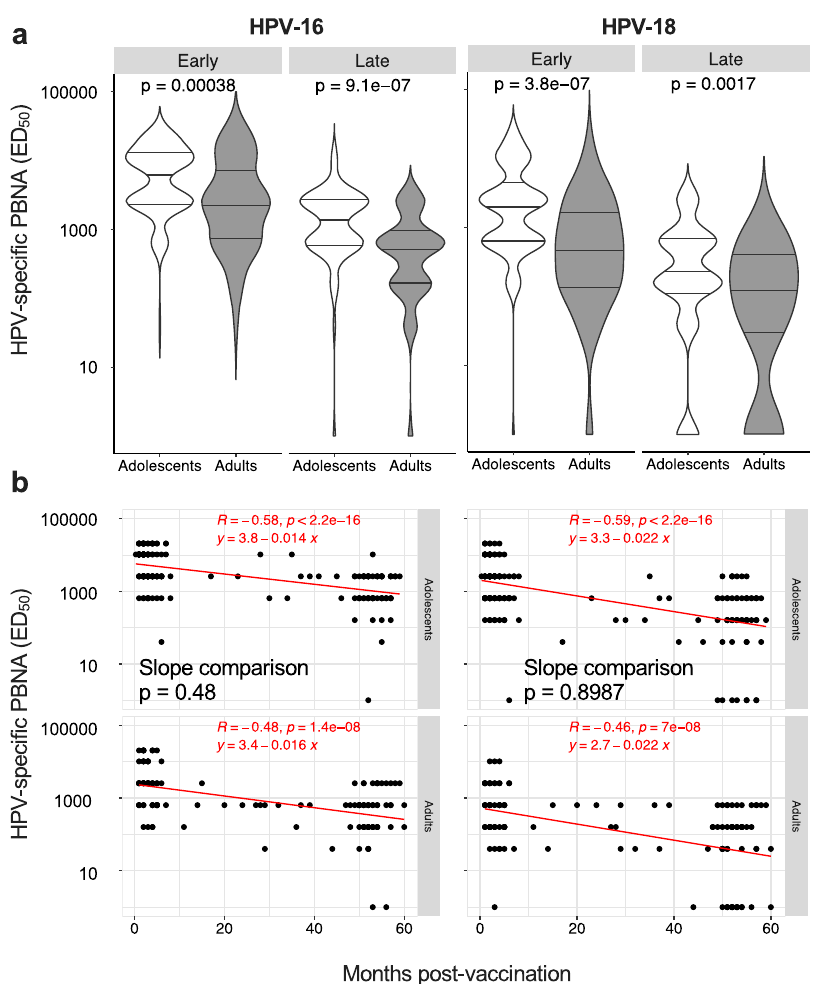
Fig. 3 Induction and maintenance of HPV-speci fi c neutralizing antibodies. a , b HPV-16 and HPV-18-speci fi c speci fi c nAbs were measured by the PBNA, reported as ED 50 , shown as violin plots ( a ) and correlated with the months post-vaccination ( b ); n = 116 and n = 70 for adolescents of the “ Early cohort ” and the “ Late cohort ” , respectively; n = 57 and n = 71 for adults of the “ Early cohort ” and the “ Late cohort ” , respectively. Statistical signi fi cance was determined by the Mann – Whitney ( a ) and Spearman ’ s rank correlation ( b ) and all p -values are shown. The lines in the violin plots represent the median and the IQR, while the width of violins represents the density (frequency of values). The equation of the regression lines has to be intended as: Log(y) = q + mx, and the comparison between slopes (adolescents vs adults) was calculated by ANCOVA ( b ). “ Early cohort ” , Early; “ Late cohort ” ,